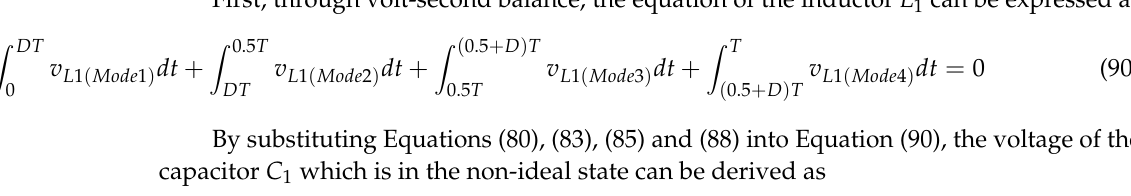
Figure 18. Equivalent circuit operating during [(0.5 + D) T , T ].